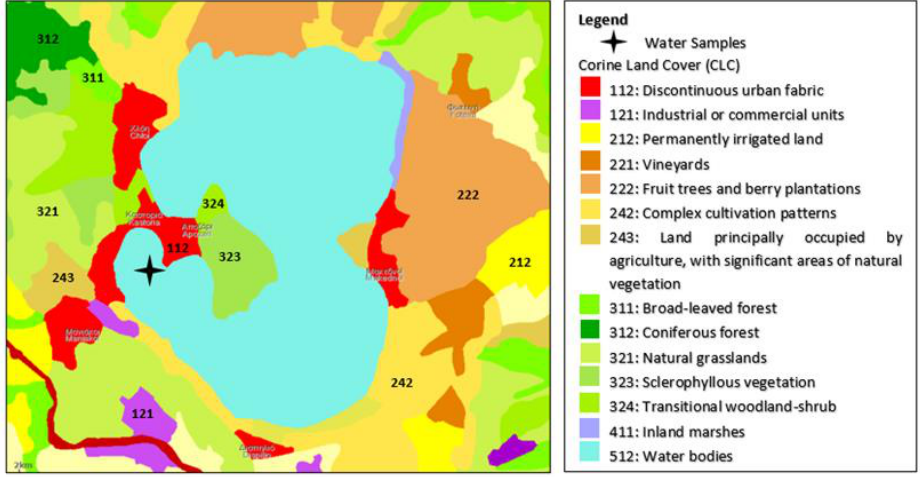
Figure 3. Map and sampling site (black mark) of Lake Kastoria (40°30′46.8″ N 21°15′49.8″ E).